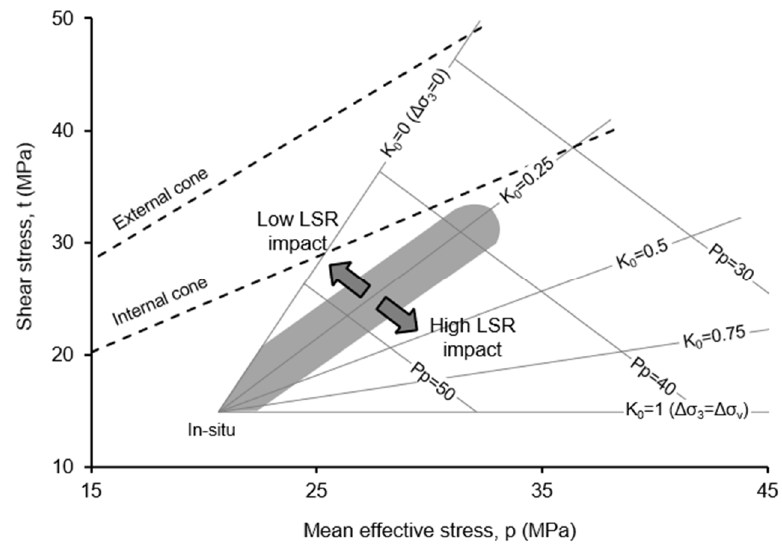
Figure 11. Stress paths in t - p plane for different Ko and LSR condition of the mid reservoir regions in normal and reverse fault geometries.